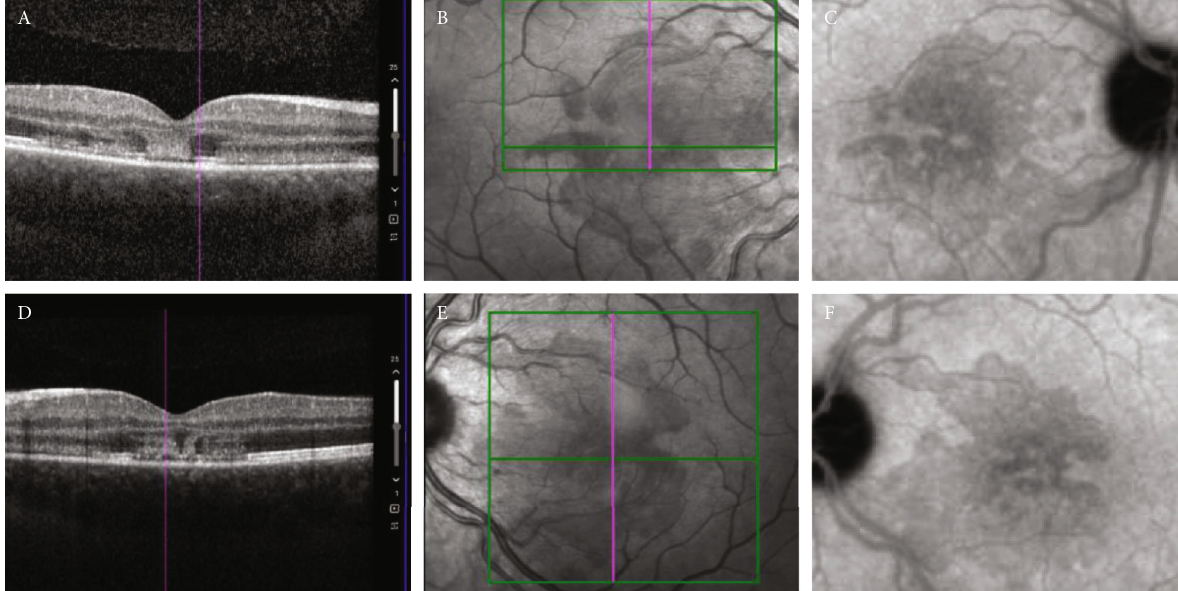
Figure 1: (a, d) Optical coherence tomography of the right and left eyes. Remarkable for distortion and hyperre fl ectivity of the outer retinal layers and disruption of the ellipsoid zone, with preservation of the retinal pigment epithelium (RPE). (b, e) Corresponding infrared re fl ectance photographs of the right and left eyes. Remarkable for hypore fl ective macular lesions that correspond to areas of hypo fl uorescence seen in the indocyanine angiograms. (c, f) Late phase indocyanine green angiography of the right and left eye. Remarkable for mottled hypo fl uorescent macular lesions that correspond to the hypopre fl ective macular lesions seen on the infrared re fl ectance